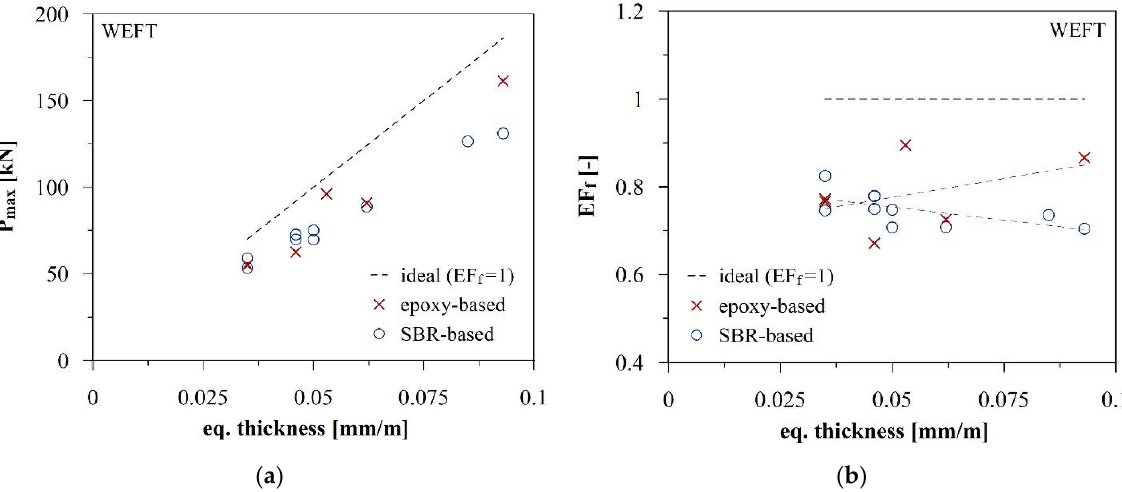
Figure 5. Average maximum load ( a ) and fabric efficiency ( b ) vs. equivalent thickness of the investigated textiles in the weft direction.